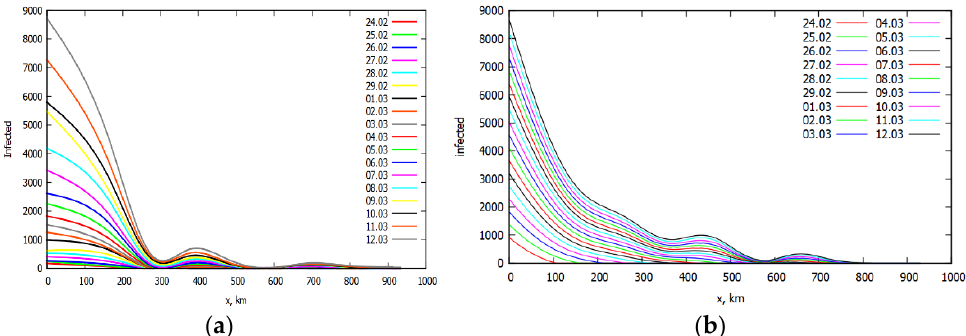
Figure 3. Graphs of the studied value 𝑛 𝑀 (𝑡, 𝑥) for Italy: ( a ) real data; ( b ) theoretical results.